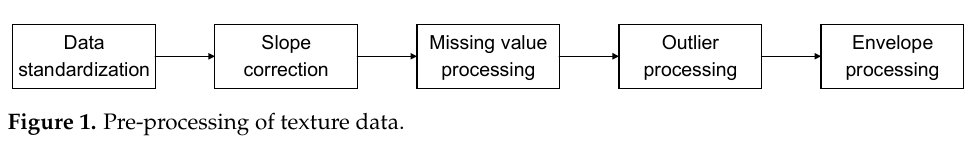
Figure 1. Pre-processing of texture data.